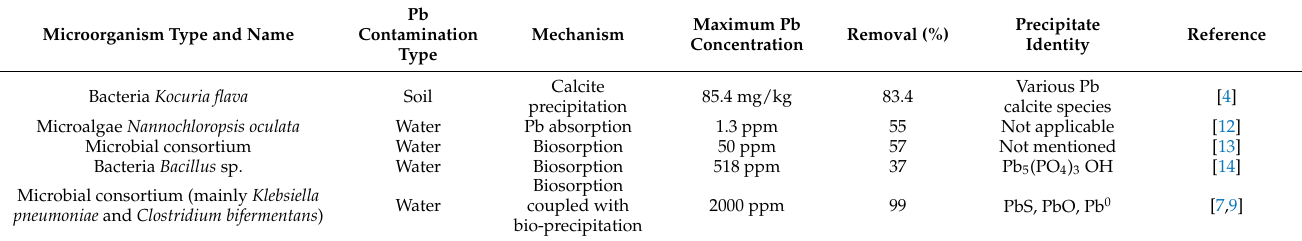
Table 1. Pb bioremediation examples compared to the current